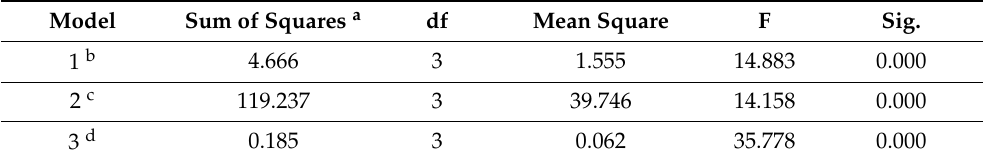
Table 14. Absolute values of residuals and banks performance model